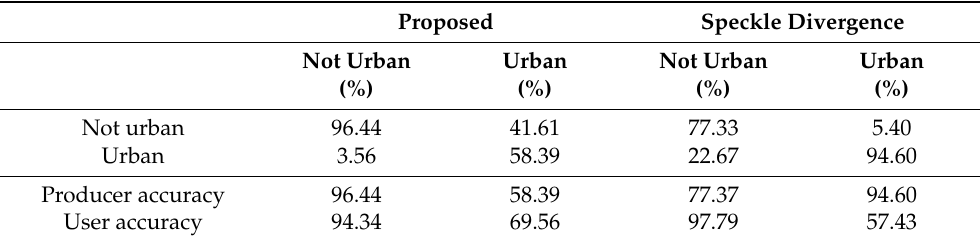
Table 4. Caserta area: confusion matrix for the urban/not urban classification using reference data derived from the Urban Atlas. Proposed methodology—overall accuracy: 91.79%, kappa coefficient: 0.58. Urban density windows ~150 m and ~450 m. Speckle divergence: overall accuracy: 81.5%, kappa coefficient: 0.59. Threshold set to